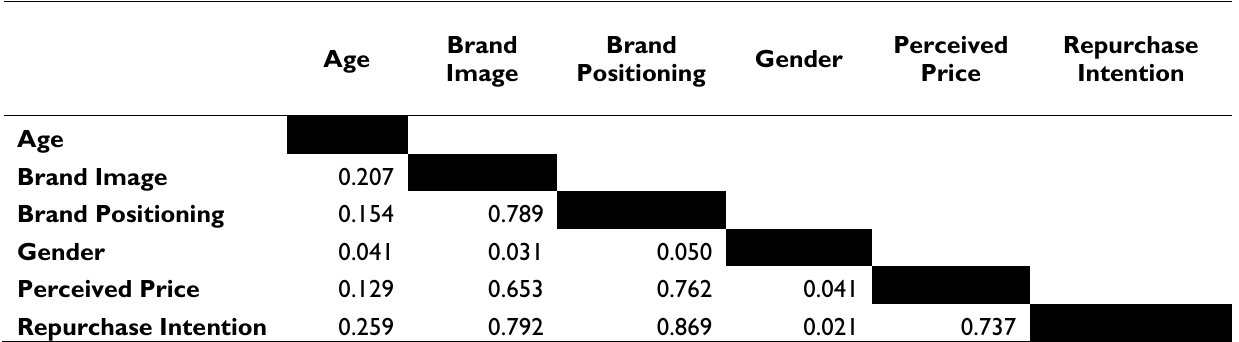
Table 4. Heterotrait-Monotrait Ratio